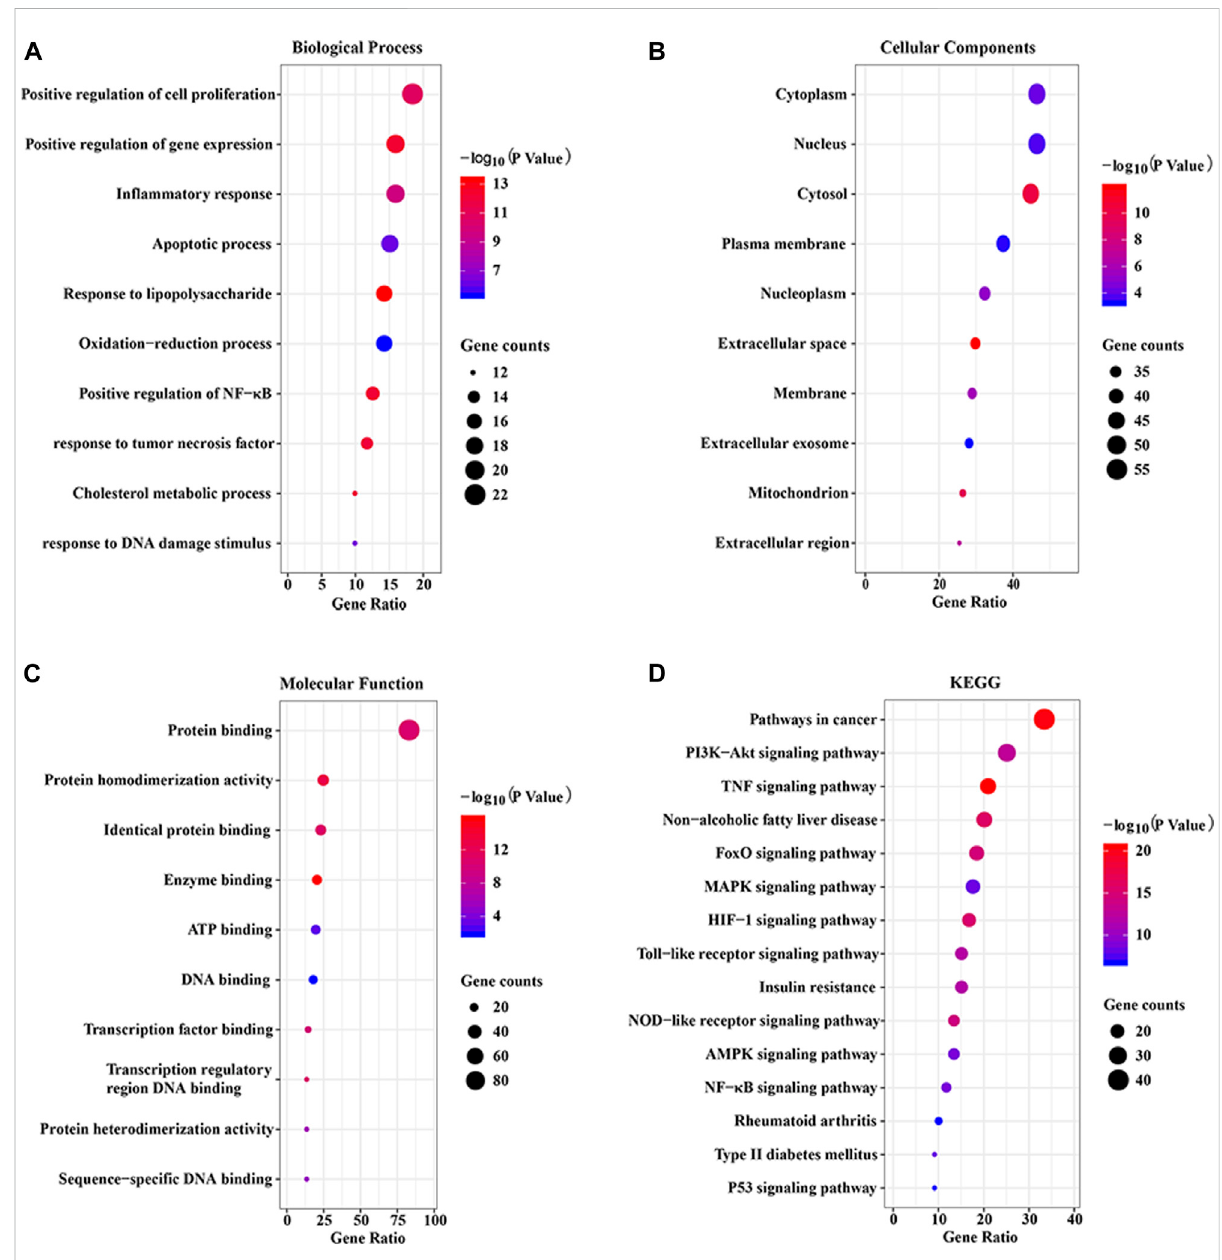
FIGURE 5 GO and KEGG enrichment analysis of the putative targets. (A) The top 10 signi fi cantly enriched terms in biological process (BP); (B) The top 10 signi fi cantly enriched terms in cellular component (CC); (C) The top 10 signi fi cant enriched terms in molecular function (MF); (D) The top 15 signi fi cantly enriched terms in KEGG pathway